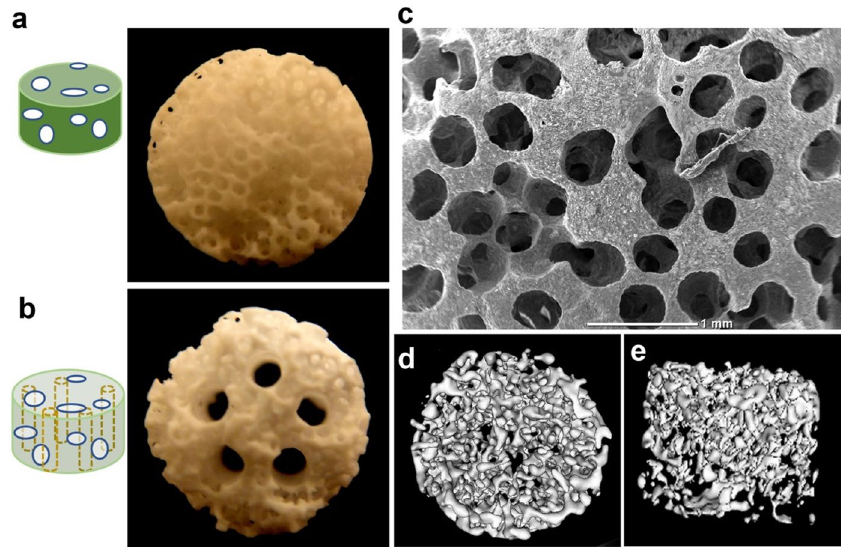
Figure 1. Images of scaffolds: two types of β-TCP scaffolds: ( a ) non-channeled porous scaffold; ( b ) porous scaffold with five straight channels. The diameter of the channel is 1 mm; ( c ) scanning electronic microscopic morphology of the non-channeled porous scaffold. Micro-CT images indicate the tortuosity of interconnected pores in the scaffold from top view ( d ) and side view ( e